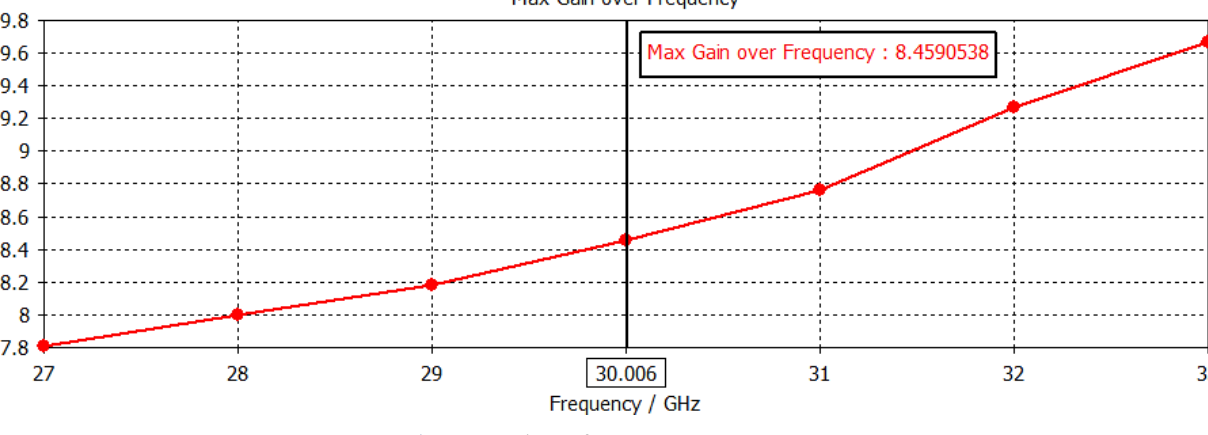
Figure 7. Gain Performance vs. Frequency